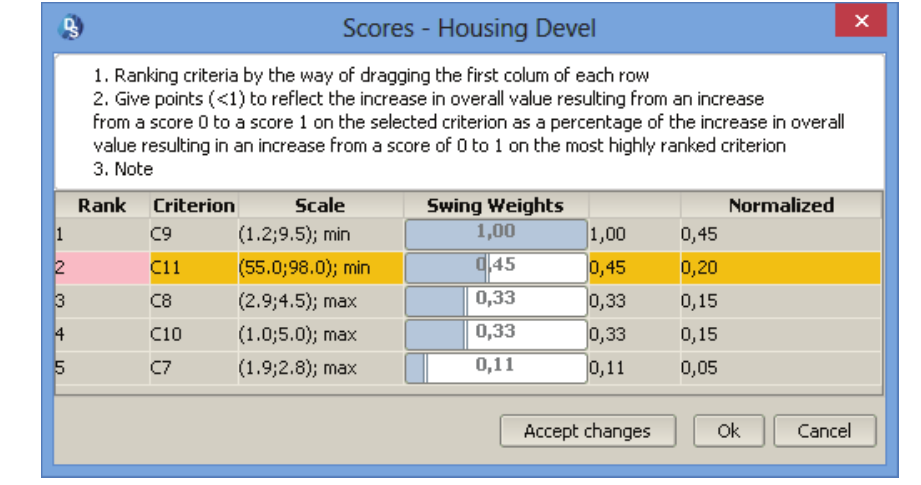
Fig.6. DecernsMCDA : weighting criteria using swing method.